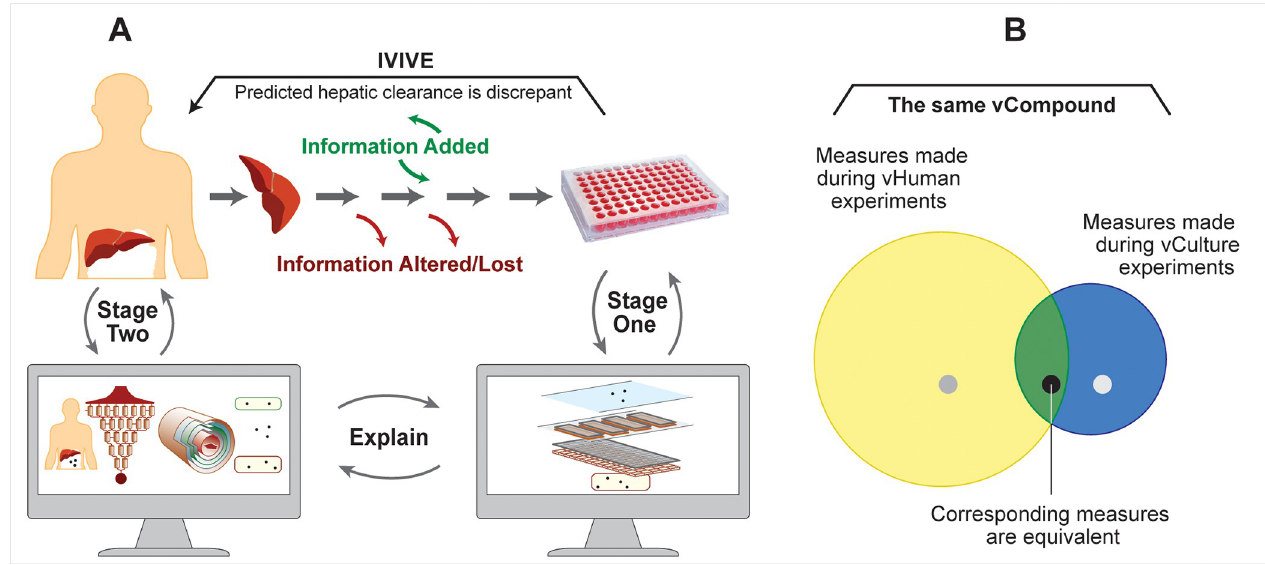
Fig 1. Discovering plausible mechanism-based explanations contributing to IVIVE discrepancies. (A) Starting with a failed IVIVE prediction of hepatic clearance, the plan requires vCulture and vHuman analogs that have achieved multiple validation targets. Stage One establishes a direct quantitative mapping between measures of removal of vCompound during vCulture experiments and the data used to compute intrinsic clearance. Independently, Stage Two establishes a direct quantitative mapping between vCompound removal measures during vHuman experiments and the data used to compute hepatic clearance. We then explain vCompound disposition and removal differences and use that information to posit explanations for the observed IVIVE discrepancy. (B) The blue and yellow circles illustrate comparable per vHPC measures of disposition and removal for different vCompound properties. Measures from each system are quantitatively equivalent within the area of overlap. The black circle illustrates a vCompound that achieves the cross-system validation target (see text), whereas the two grey circles illustrate one that does